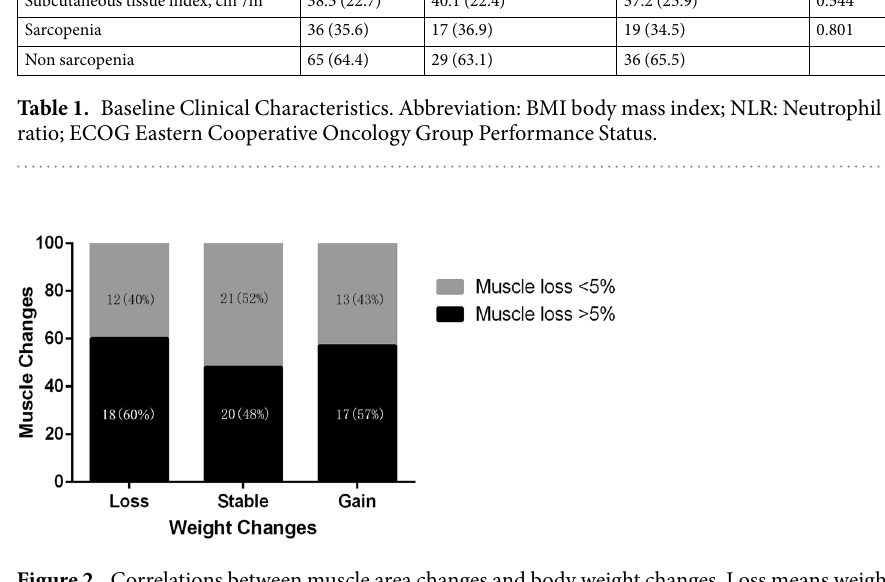
Figure 2. Correlations between muscle area changes and body weight changes. Loss means weight loss ≥ 5%, stable means weight loss < 5% and weight gain < 2%, gain means weight gain >